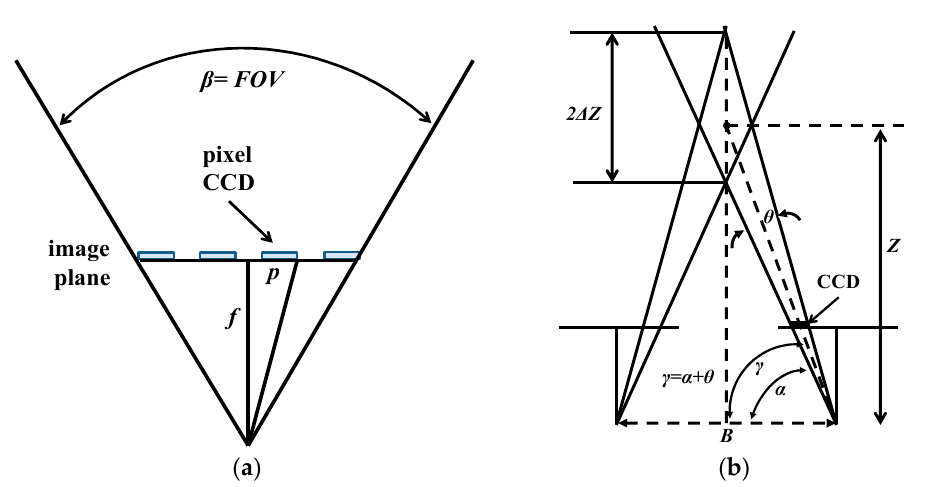
Figure 9. Stereovision system geometry with parallel optical axes (images from [73]): ( a ) mapping of where β determines the Field of View (FOV) angle. 3D point P ( X ,Y,Z) onto image planes; ( b ) geometric parameters on similar triangles.